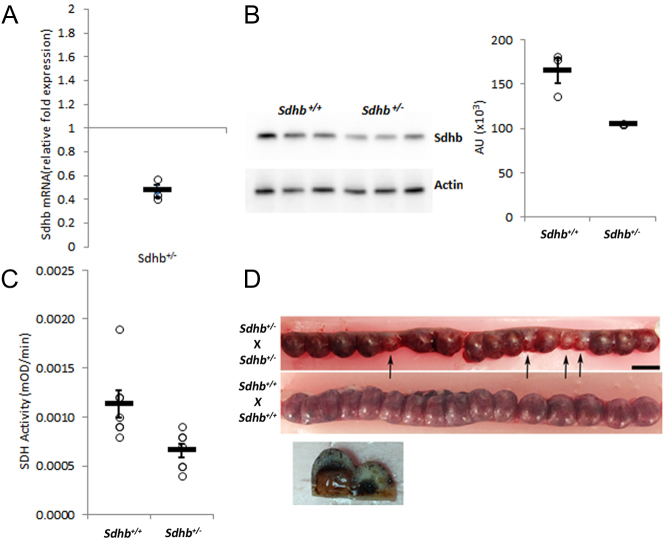
Molecular and functional consequences of heterozygous Sdhb deletion. (A, B and C) Comparisons of liver tissue from 2-week-old heterozygous (Sdhb+/-) and WT (Sdhb+/+) rats. (A) Decreased Sdhb mRNA (n = 3 animals for each group, each point done in triplicate *P < 0.05). (B) Protein expression with densitometric analysis n = 3 *P < 0.05; and (C) decreased Sdh enzyme activity (n = 7 samples for each group, individual points done in duplicate) *P < 0.05. (D) Opened uteri from 12-day-old gravid rats showing stalled embryos in a representative heterozygous cross (top) compared to WT (bottom). Nine of 31 embryos examined were stalled in Sdhb+/-x Sdhb+/- vs 1 of 31 in in WT pregnancies (P = 0.0125).